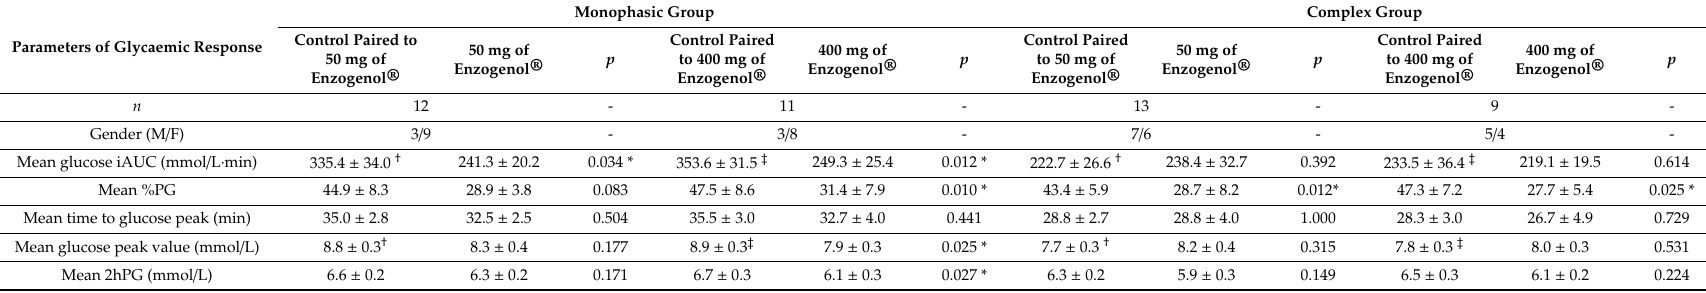
Table 2. Parameters of glycaemic response in participants classified as having either a monophasic or complex glucose curve shape at control visit and treatments with 50 and 400 mg of Enzogenol ®